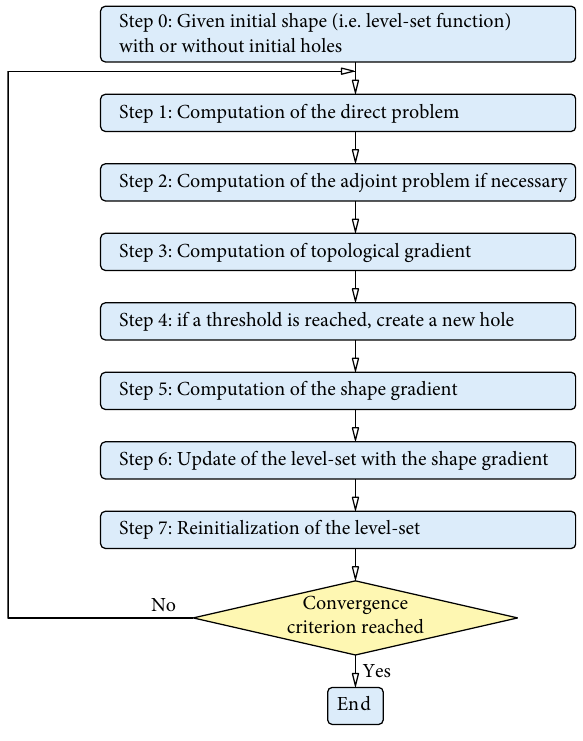
Figure 1: Proposed